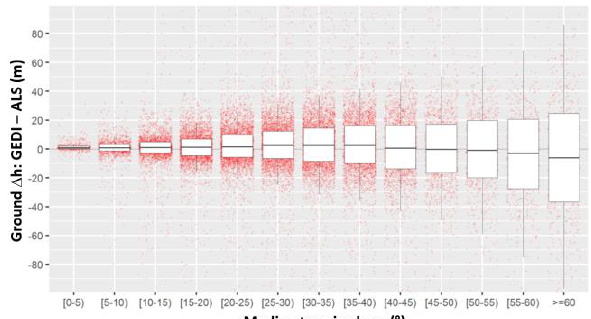
Figure 8. Error distribution of terrain height grouped by terrain slope.